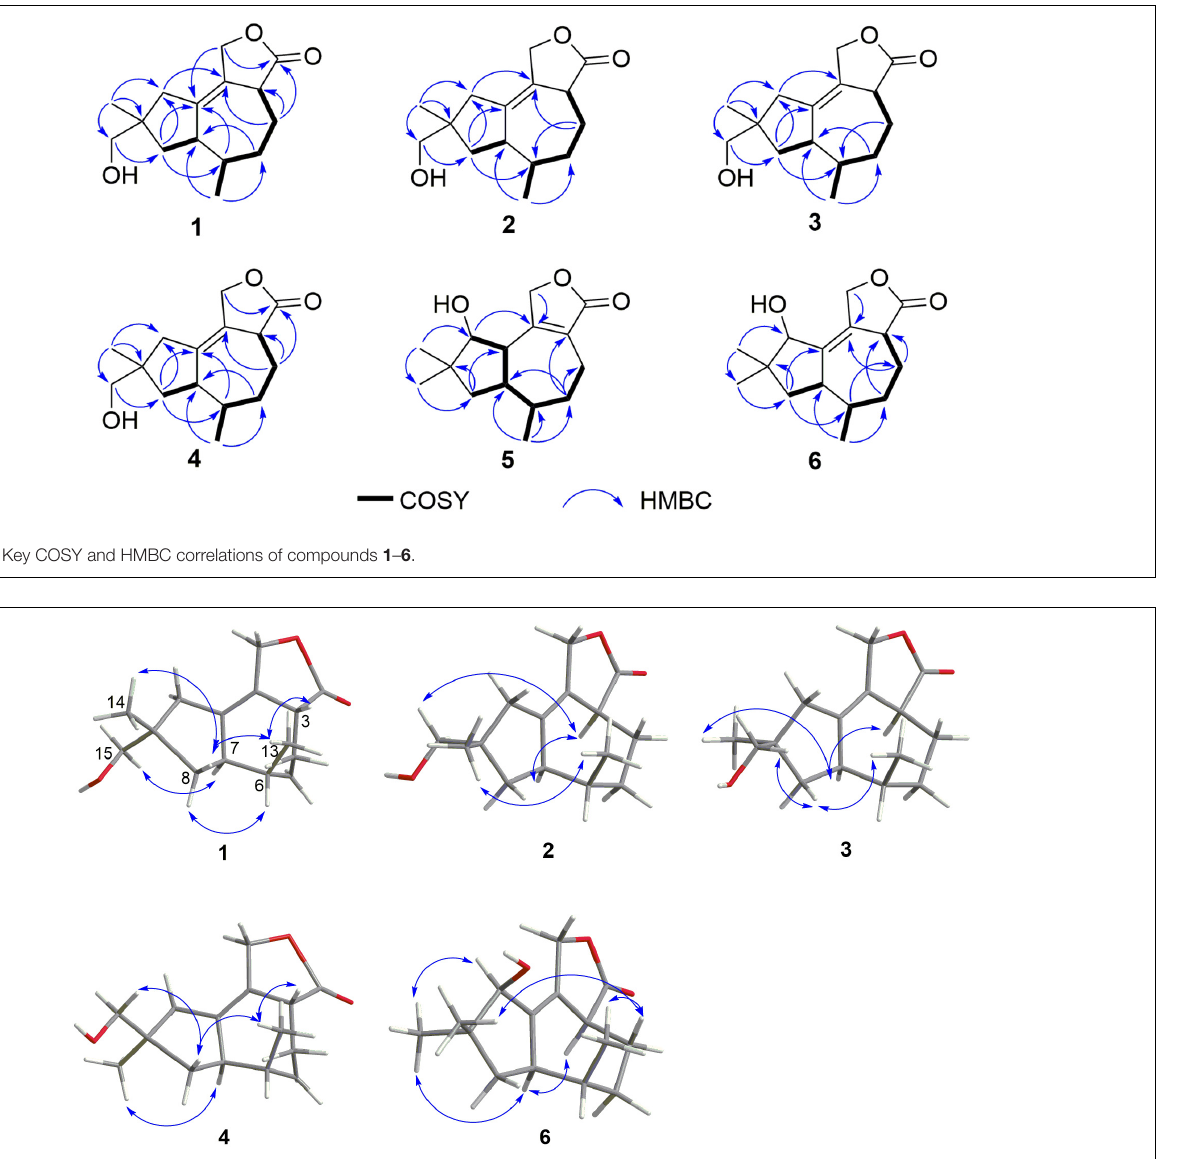
FIGURE 4 | Key NOESY correlations of compounds 1 – 4 and 6